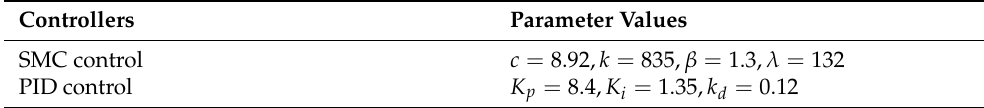
Table 5. Controller parameters.